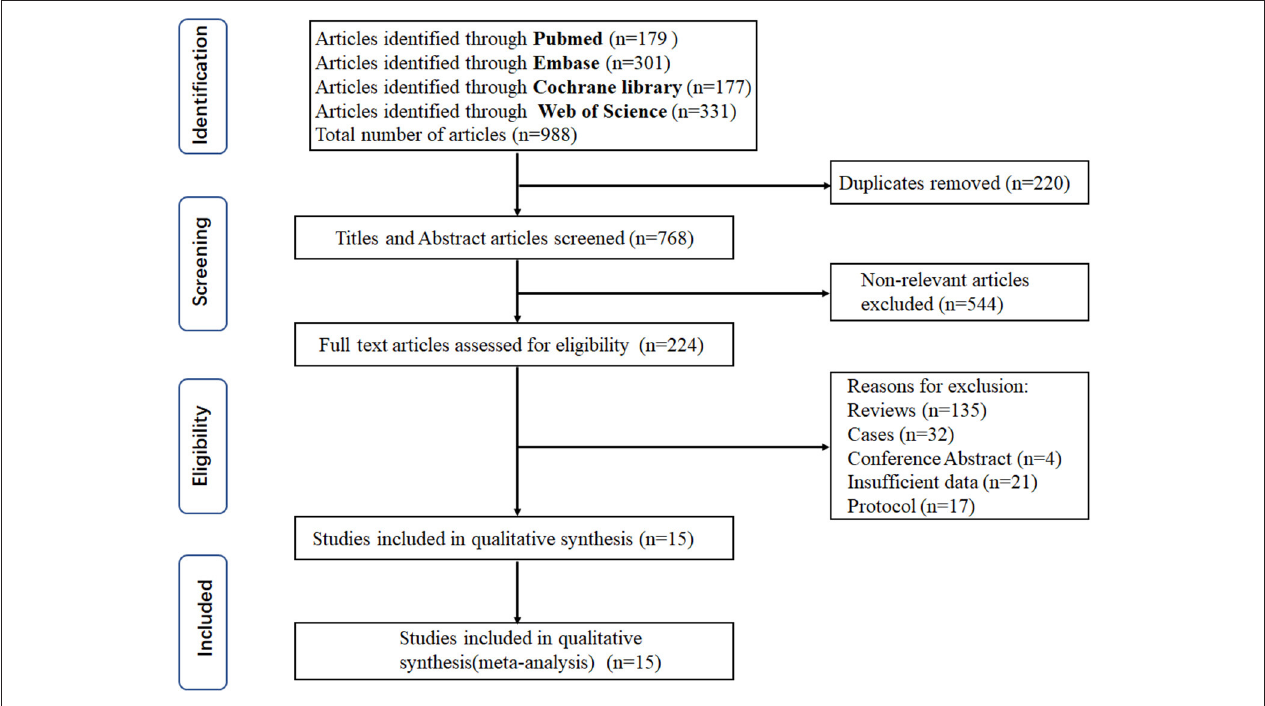
FIGURE 1 | The flow diagram of study selection for this